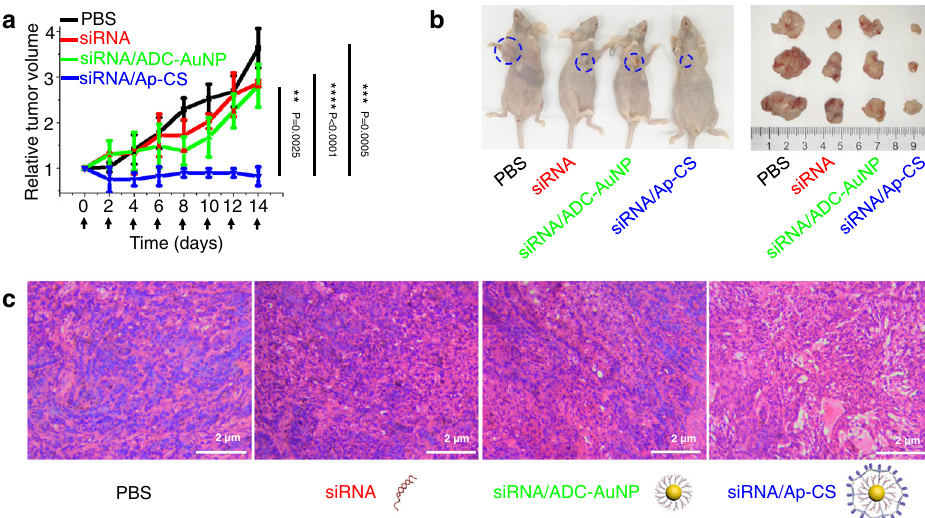
Fig. 7 In vivo therapeutic ef fi cacy of siRNA/Ap-CS against malignant tumor in A549 NSCLC xenograft murine model. a Tumor growth curves during treating with siPlk1 delivered by different formulations. The arrows represent the intravenous injections via tail vein. The error bar represents the standard deviation (SD). The measured data are expressed as the means ± SD ( n = 3). b Images of tumor-bearing mouse and corresponding harvested tumors 14 days after treatment with different siPlk1-encapsulated formulations. c Hematoxylin and eosin (H&E) staining-based histological images of tumor sections obtained from the same model mice as b . The histological examination was performed three times independently with similar results. ** P < 0.01, *** P < 0.001, **** P < 0.0001, two-tailed unpaired t